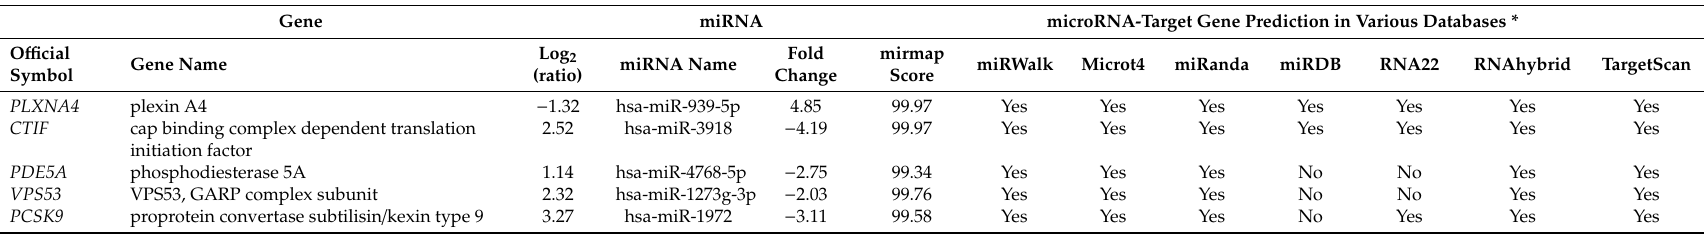
Table 1. Potential altered miRNA–mRNA interactions in idiopathic pulmonary fibrosis (IPF) fibroblasts treated with epigallocatechin gallate (EGCG). Gene miRNA microRNA-Target Gene Prediction in Various Databases *